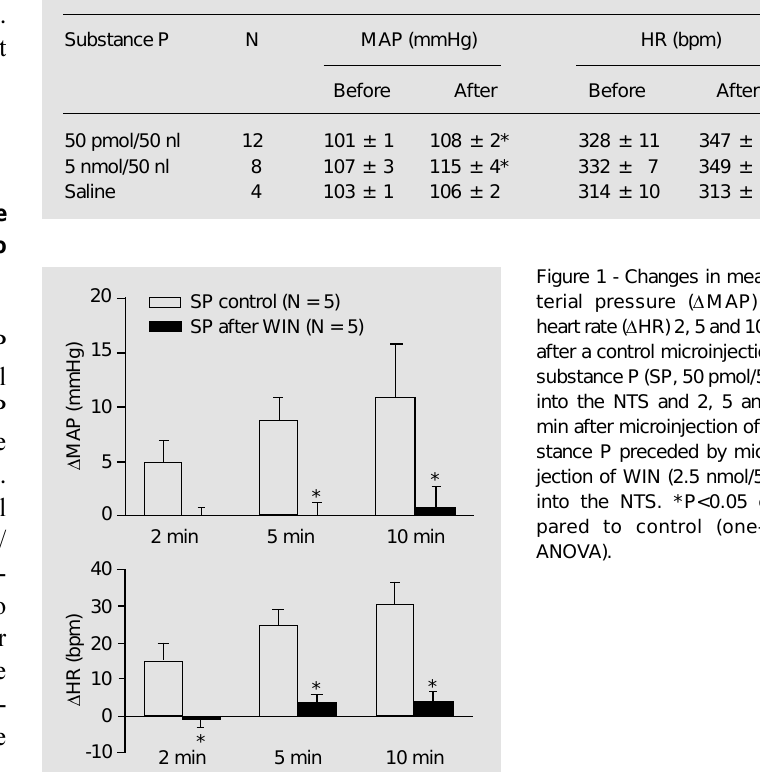
Table 1 - Basal mean arterial pressure (MAP) and heart rate (HR) before and 2 min after bilateral microinjection of substance P (50 pmol/50 nl and 5.0 nmol/50 nl) or saline into the NTS of three different groups of